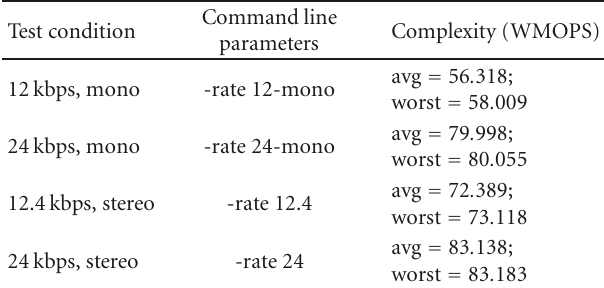
Table 5: Complexity of AVS-M encoder. Table 6: Complexity of AVS-M